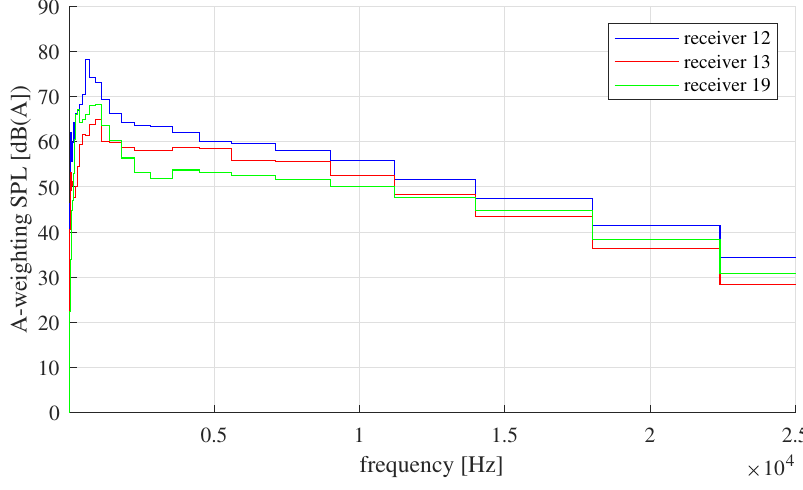
Figure 15. A-weighting sound pressure level provided by terce for receivers 12, 13, and